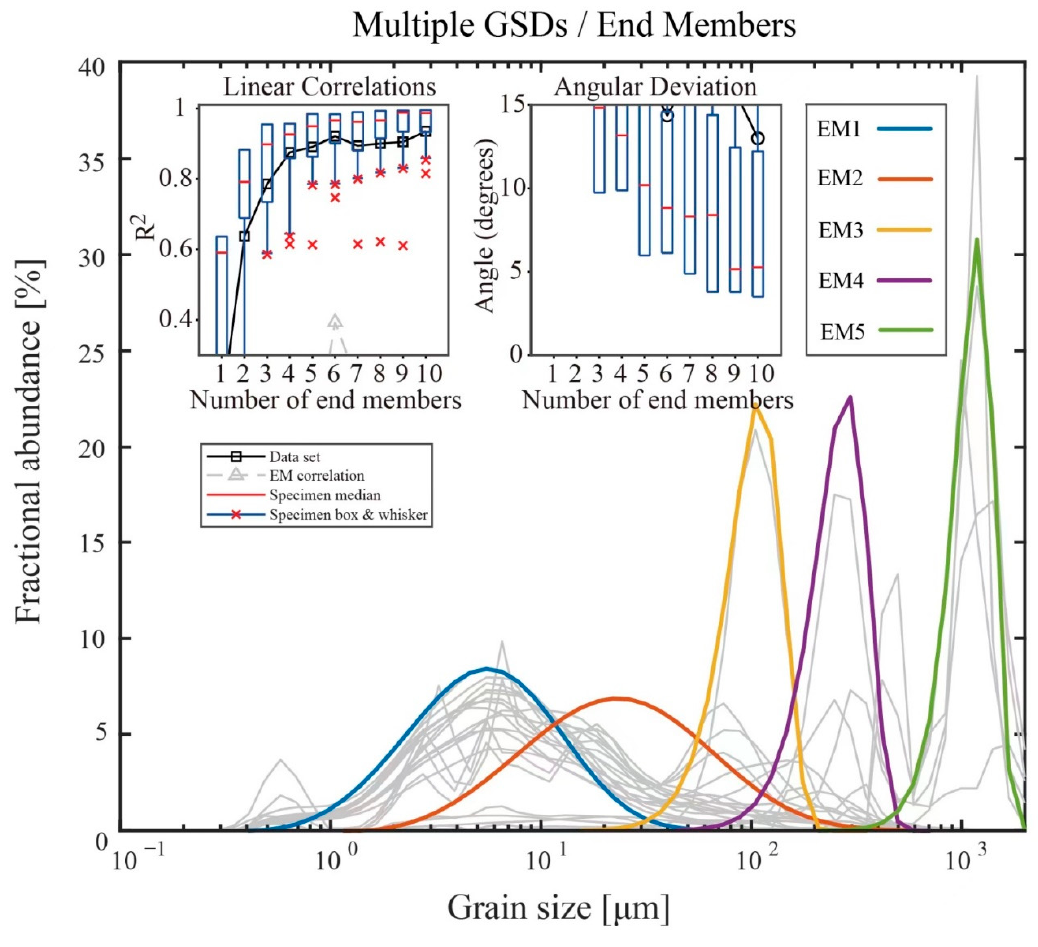
Figure 6. Endmember analysis decomposition diagram. The gray curve shows the grain size distribution of the 24 samples, and the five colored curves show the five endmember components, the R 2 values and angular deviations corresponding to different number of endmember are presented in the upper two rectangles. Table 2. Endmember parameter characteristics of EM 1 to 4 of 24 sediment samples in the Lu’erhuan River Sea area of Qinzhou Bay, Guangxi Province. Endmember